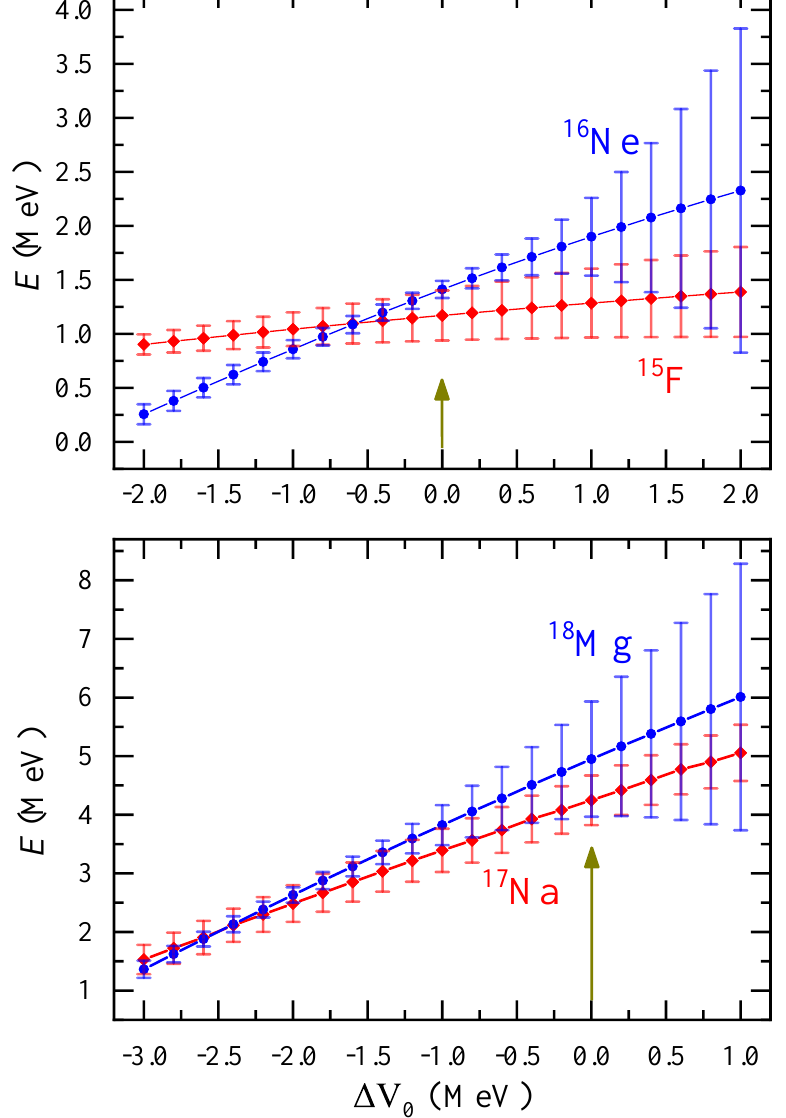
Figure 11. Calculated energies and widths (in MeV) of 15 F, 16 Ne ( upper panel ), 17 Na, and 18 Mg ( lower panel ) as a function of the difference ∆ V 0 = V 0 − V (fit) (see details in Ref. [48]). Energies are depicted by blue disks and red lozenges for even and odd nuclei, respectively. Widths are represented by segments centered on disks and lozenges. The widths of 16 Ne and 18 Mg have been multiplied by 20 for readability. Energies are given with respect to the 14 O core. The physical GSM calculation, for which V 0 = V (fit) permissions from Ref.